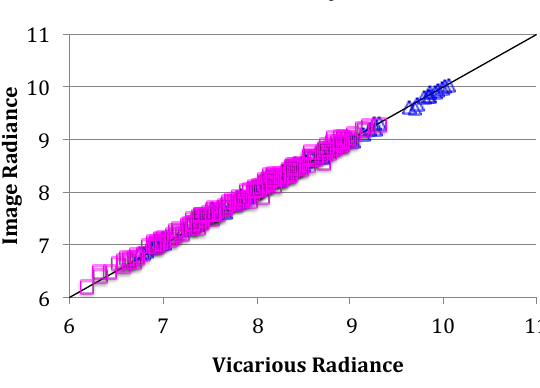
Figure 4. Calibration of Landsat 8 TIRS Band 10 using buoys that measure water temperature. The red squares indicate data from buoys deployed around the coast of the United States as collected by Rochester Institute of Technology and the blue triangles are data from buoys deployed on the Salton Sea and Lake Tahoe in California, USA, by the NASA Jet Propulsion Laboratory. Standard units of radiance are used (W/m 2 /sr/µm).